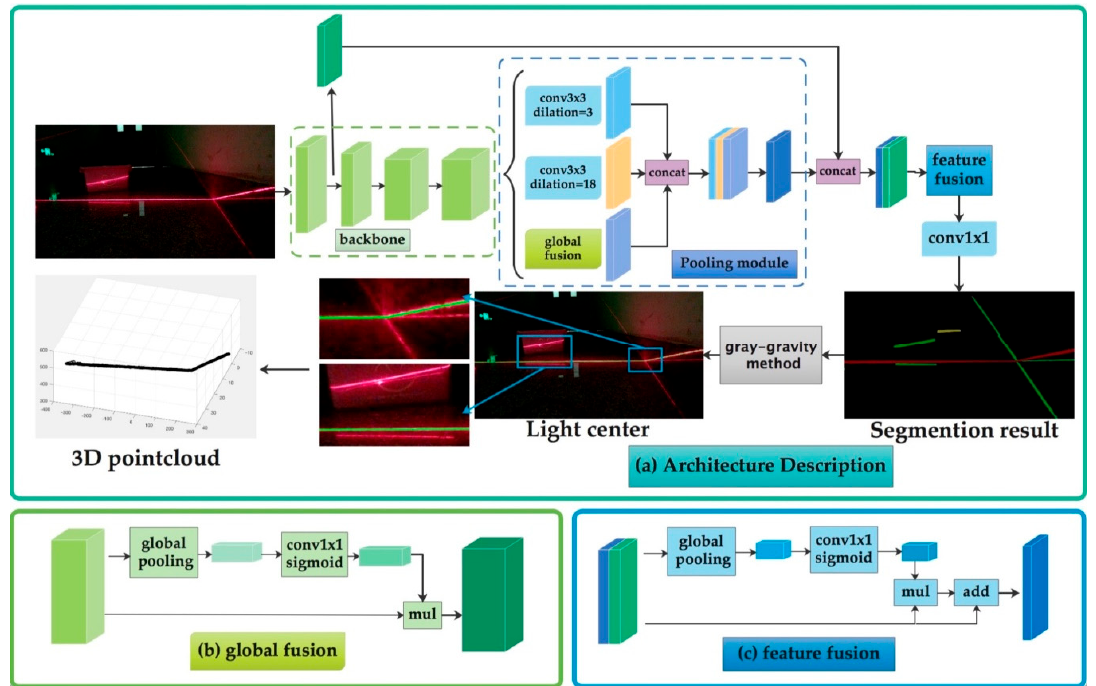
Figure 3. Overall architecture of our system. ( a ) Architecture description of our system. A laser-stripe-